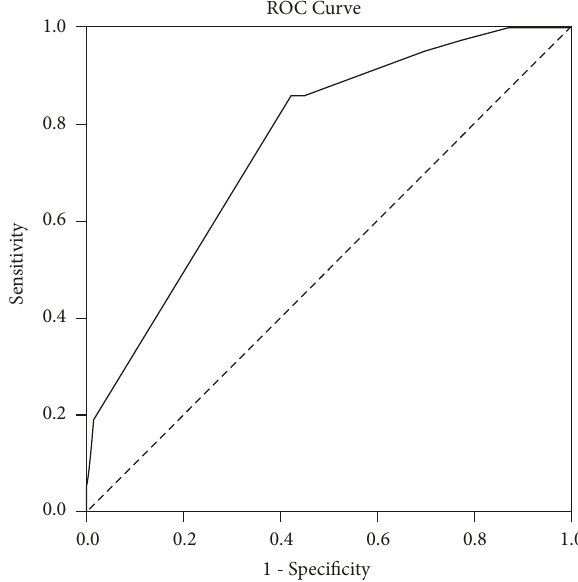
Figure 1: Area under receiver operating characteristic curve for bleeding complications at a therapeutic INR. Model included sex, age, atrial fibrillation, rs6983561, and rs13281615 for analysis. AUC is 0.761 (95% CI 0.659-0.863, p <